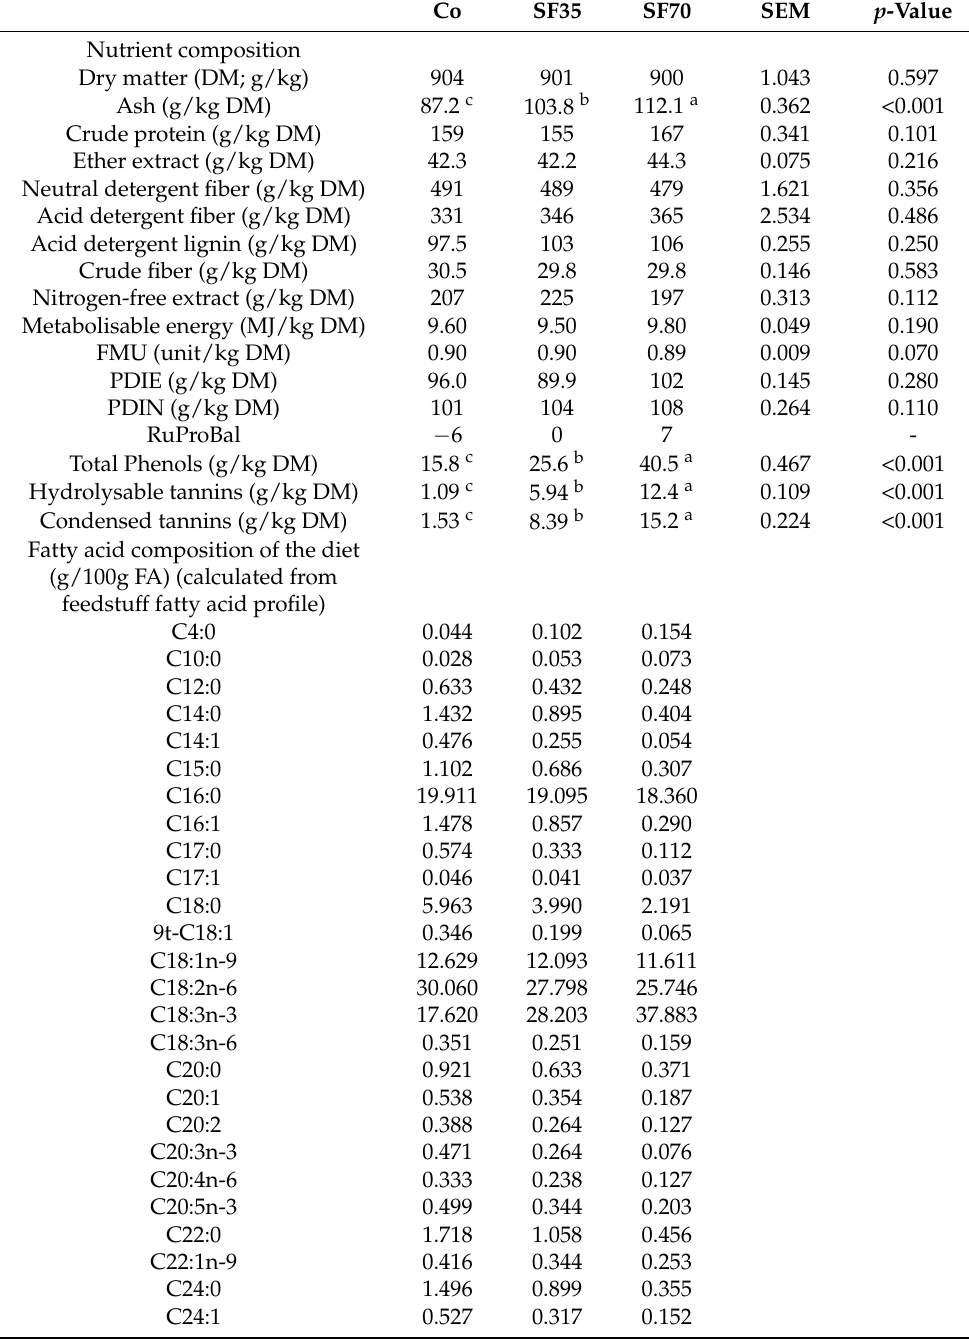
Table 3. Chemical composition of the offered diets ( n = 6 for each